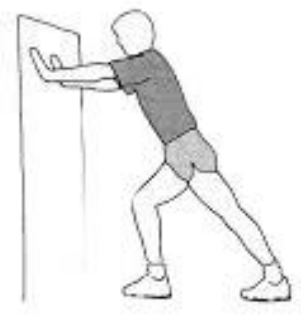
Figure 2. Calf muscle stretching exercise 1.